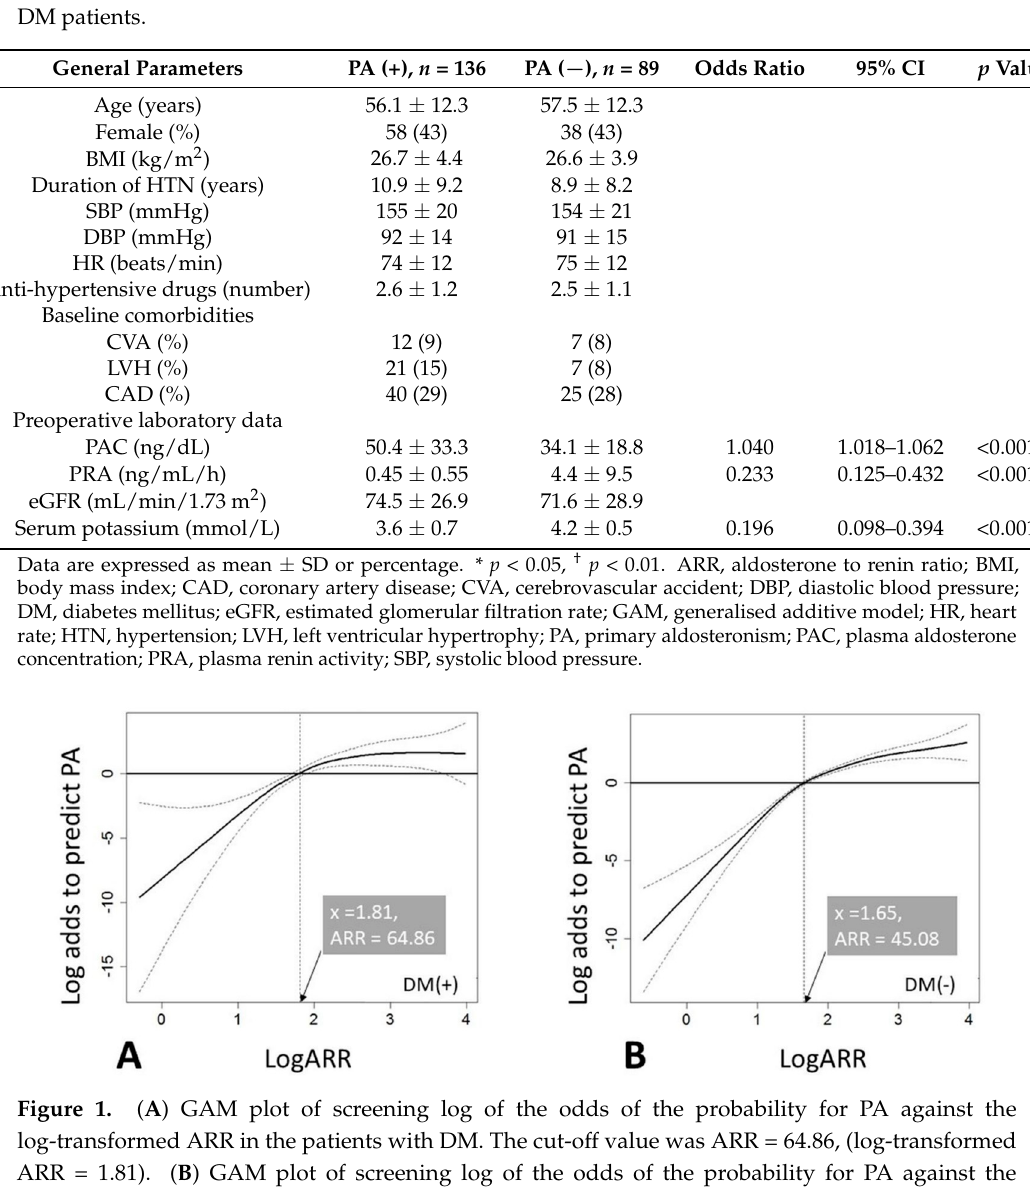
Table 3. Results of multivariable logistic regression generated for predicting the diagnosis of PA in DM patients.